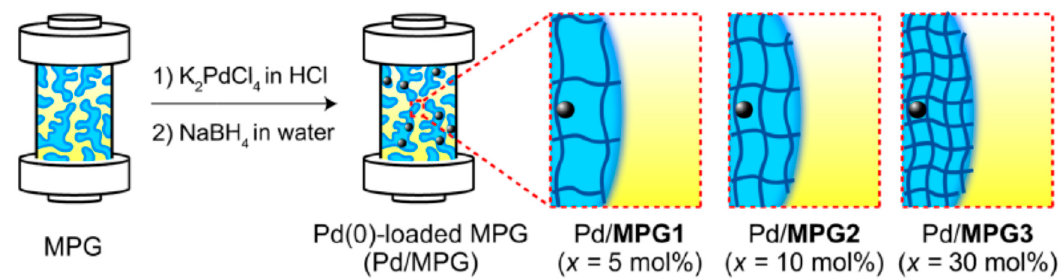
Figure 1. Immobilization of PdNPs into the gel pores of MPGs. (Reprinted from [16]).